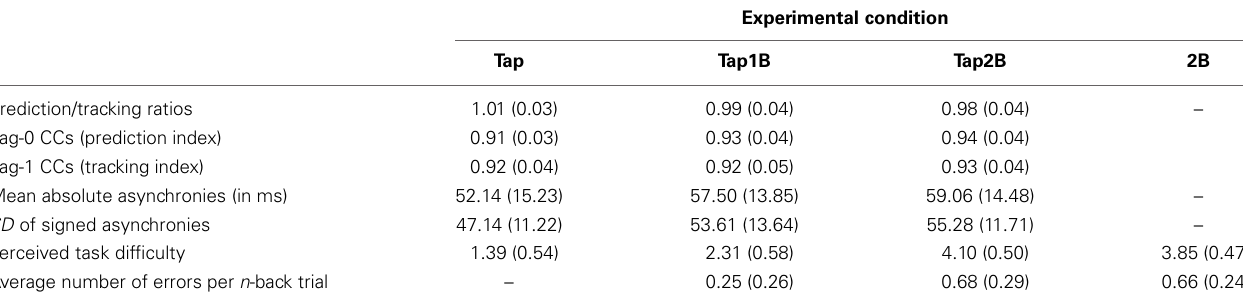
Table 1 | Summary statistics for the four experimental